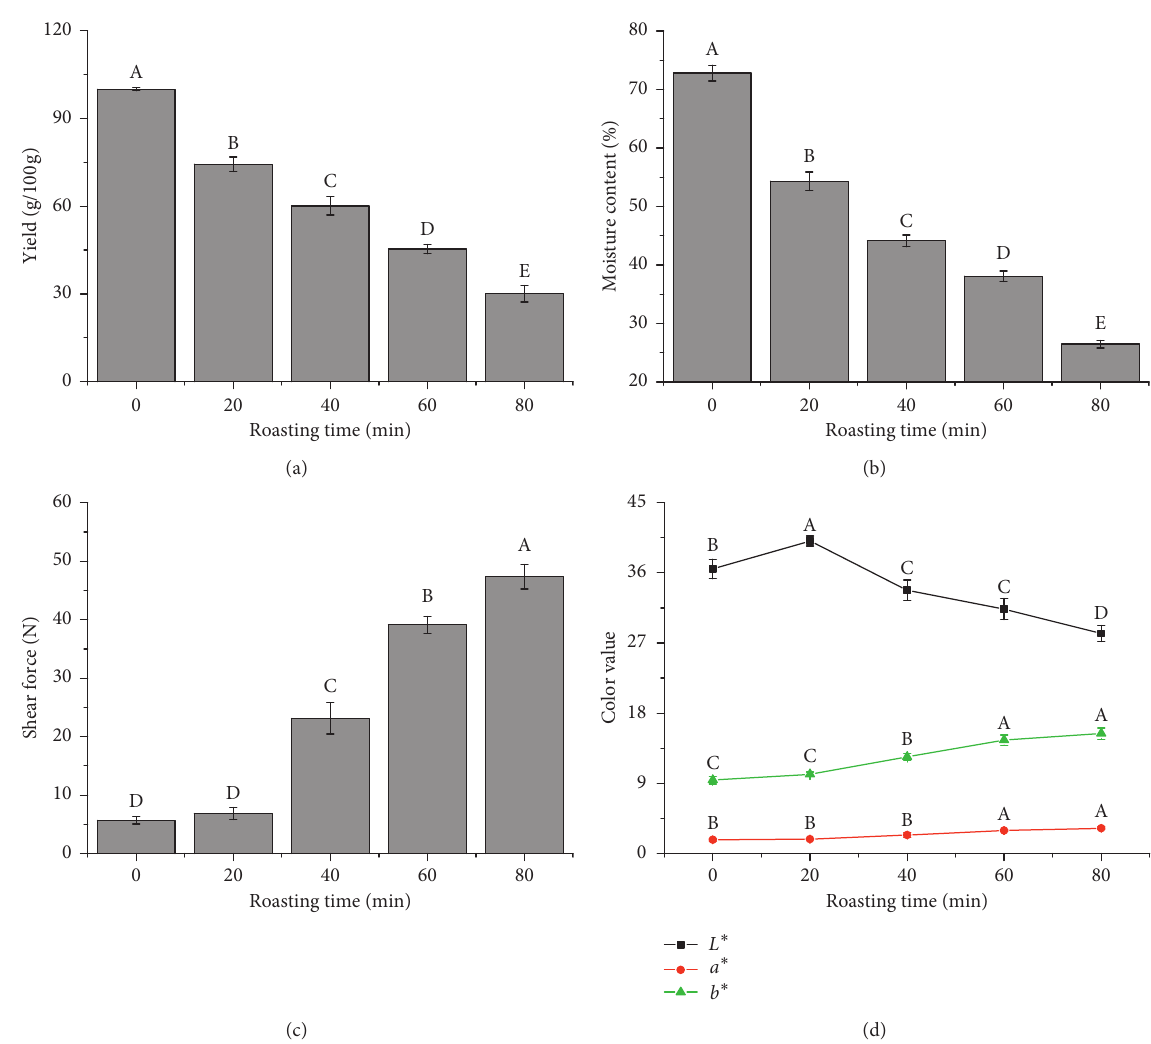
Figure 1: Quality attributes as influenced by roasting time. (a) Processing yield; (b) moisture content; (c) shear force; (d) color values. All data were reported as mean ± standard deviation ( n ≥ 3). Different lowercase letters indicate significant differences ( p < 0 .